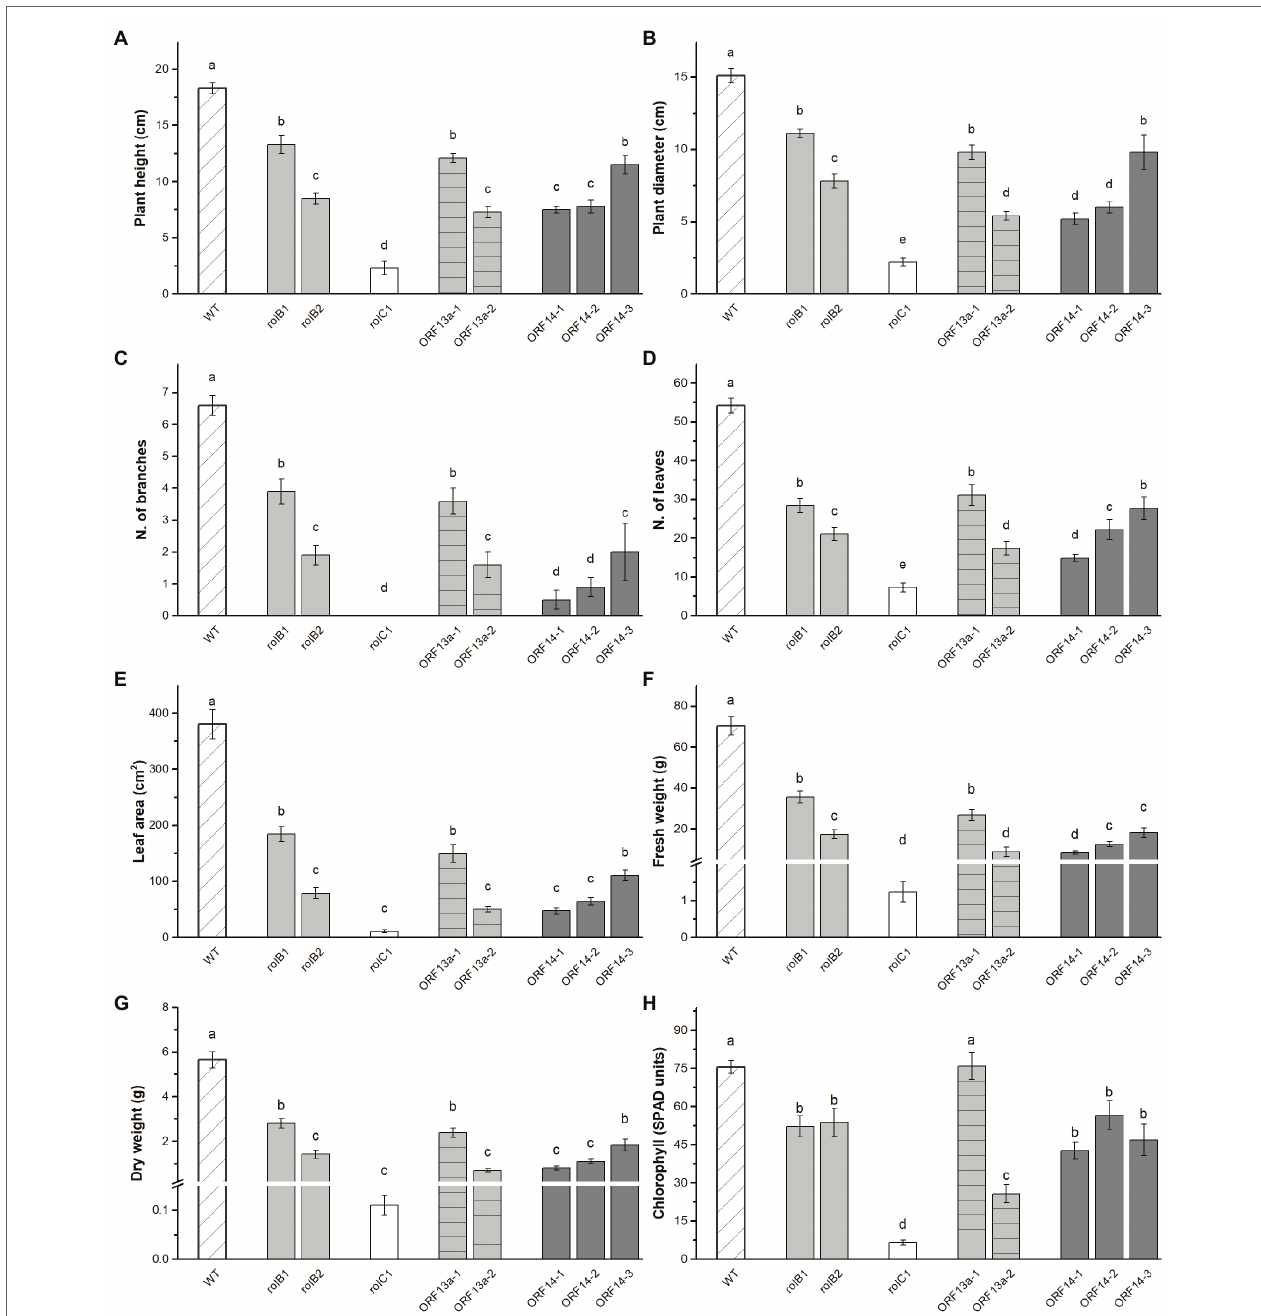
FIGURE 3 | Vegetative biometric data and chlorophyll content in leaves of plants derived from individual transformation events. (A) Plant height, (B) plant diameter, (C) number of branches, (D) number of leaves, (E) leaf area, (F) fresh weight, (G) dry weight, and (H) chlorophyll of WT K. blossfeldiana ‘Molly’ and overexpressing lines ( rol B1, rol B2, rol C1, Δ ORF13a-1, Δ ORF13a-2, ORF14-1, ORF14-2, and ORF14-3). Data columns represent the average ± SE ( n = 6–27) and different lower case letters represent statistical significance using Scott-Knot test ( p ≤